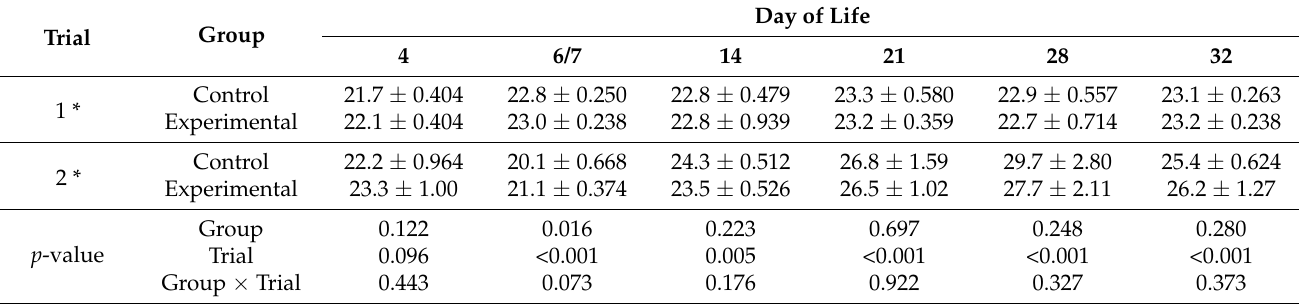
Table 2. Dry matter content (%) of excreta depending on different groups and different trials ( n = 18 each, except at d 4; n = 6) using two-factorial analysis.